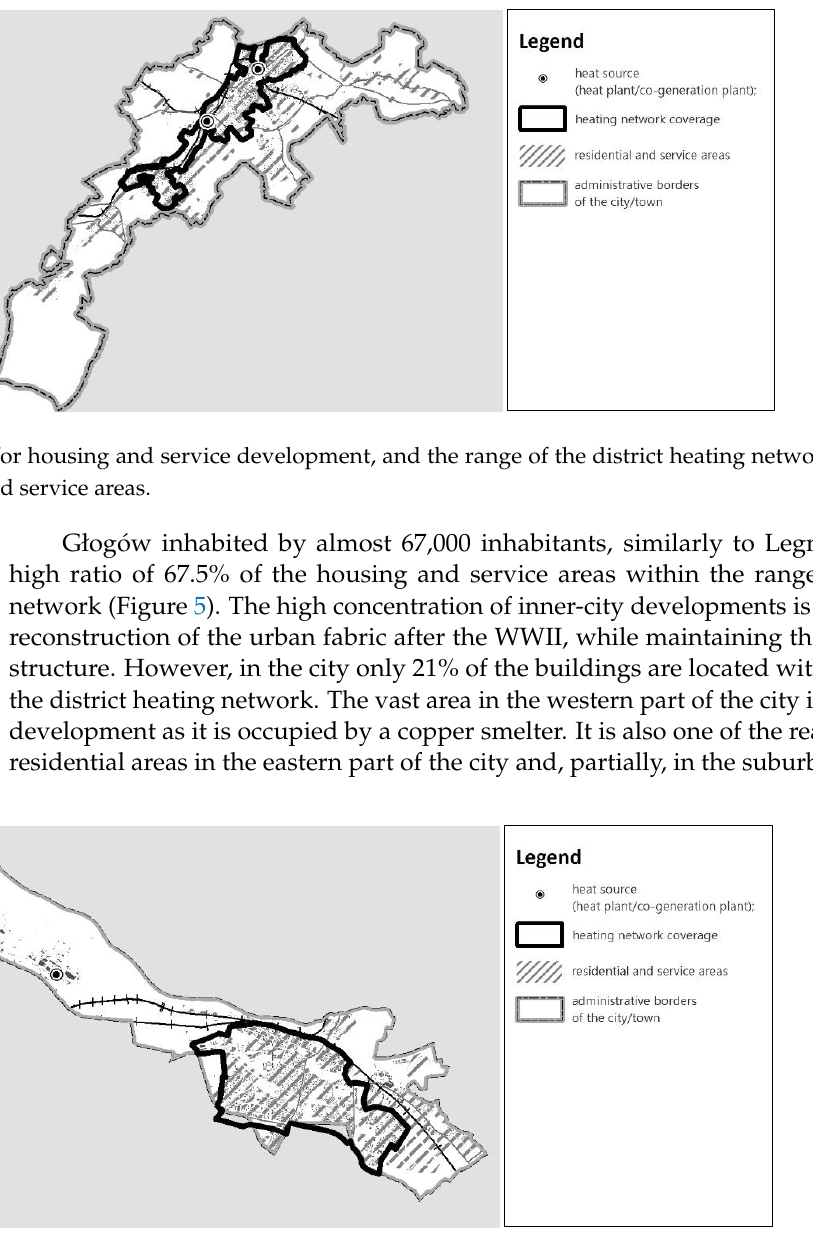
Figure 3. Areas intended for housing and service development, and the range of the district heat- ing network in Legnica. * HSAs—housing and service areas.